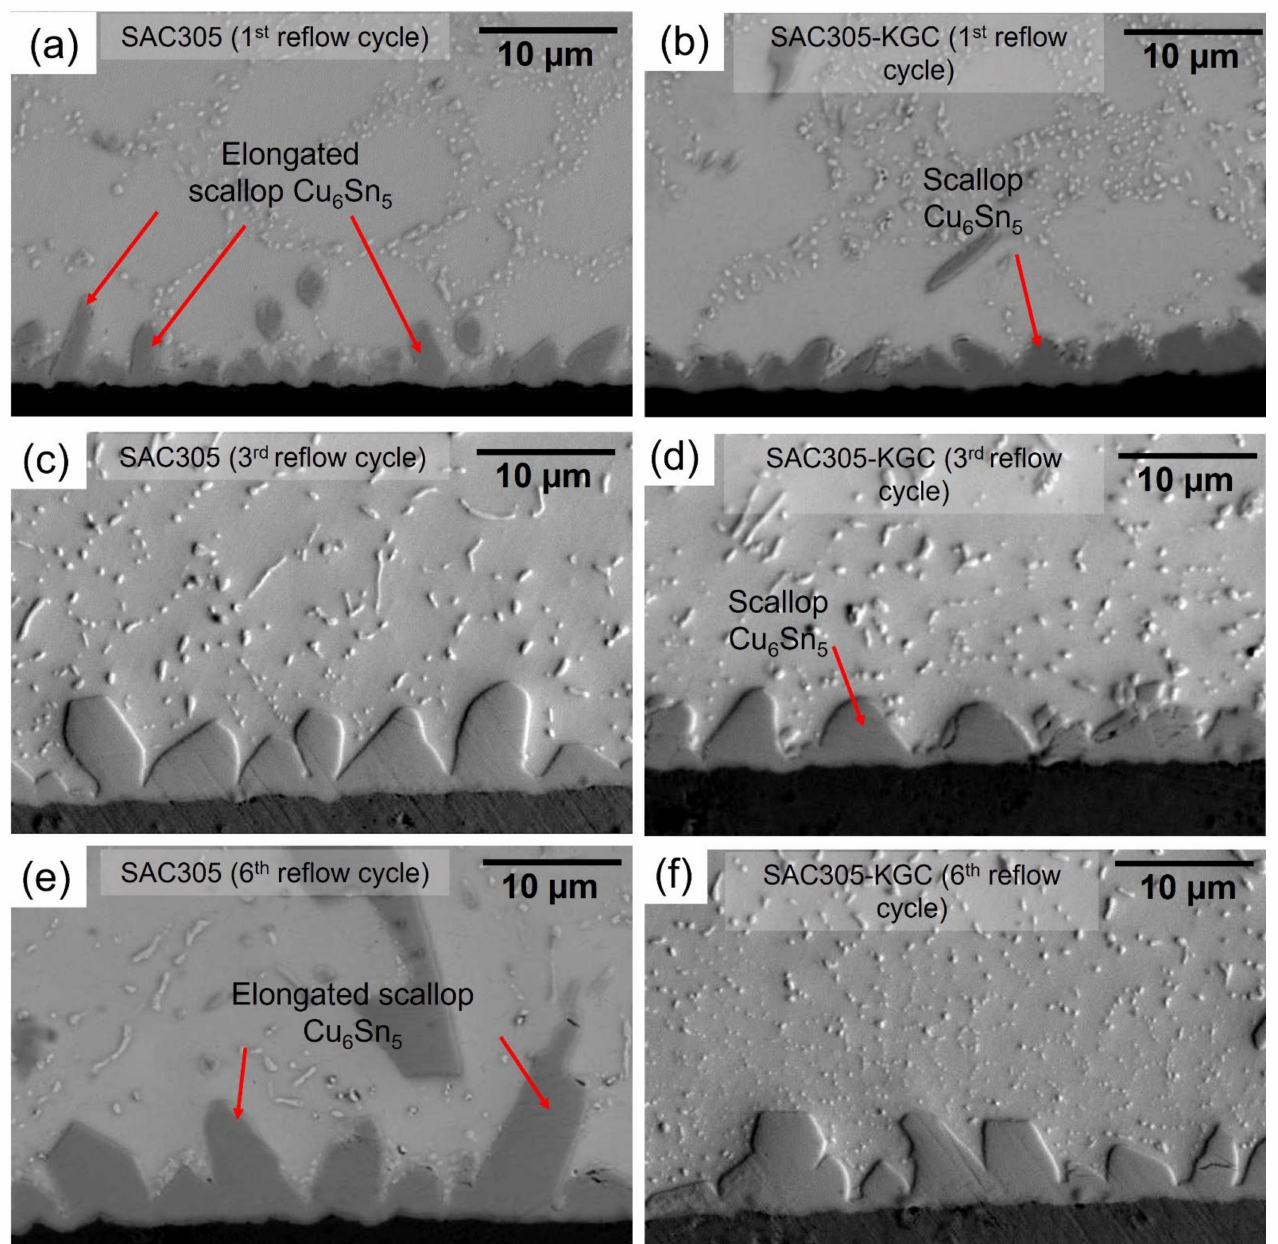
Figure 4. Cross-sectioned microstructure at the interfacial of solder joints ( a ) SAC305 at 1st reflow cycle, ( b ) SAC305-KGC at 1st reflow cycle, ( c ) SAC305 at 3rd reflow cycle, ( d ) SAC305-KGC at 3rd reflow cycle, ( e ) SAC305 at 6th reflow cycle, and ( f ) SAC305-KGC at 6th reflow